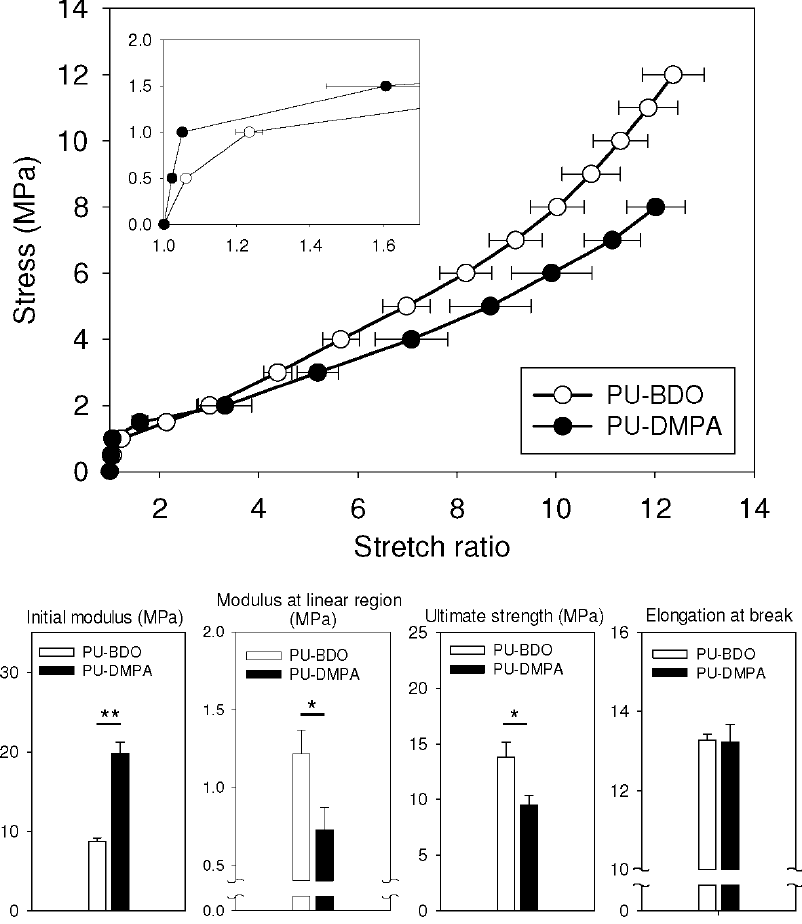
Figure 4. Average stress–stretch curves and mechanical properties of the PU-DMPA and the PU-BDO. * denotes p < 0.05, while ** denotes p < 0.001.